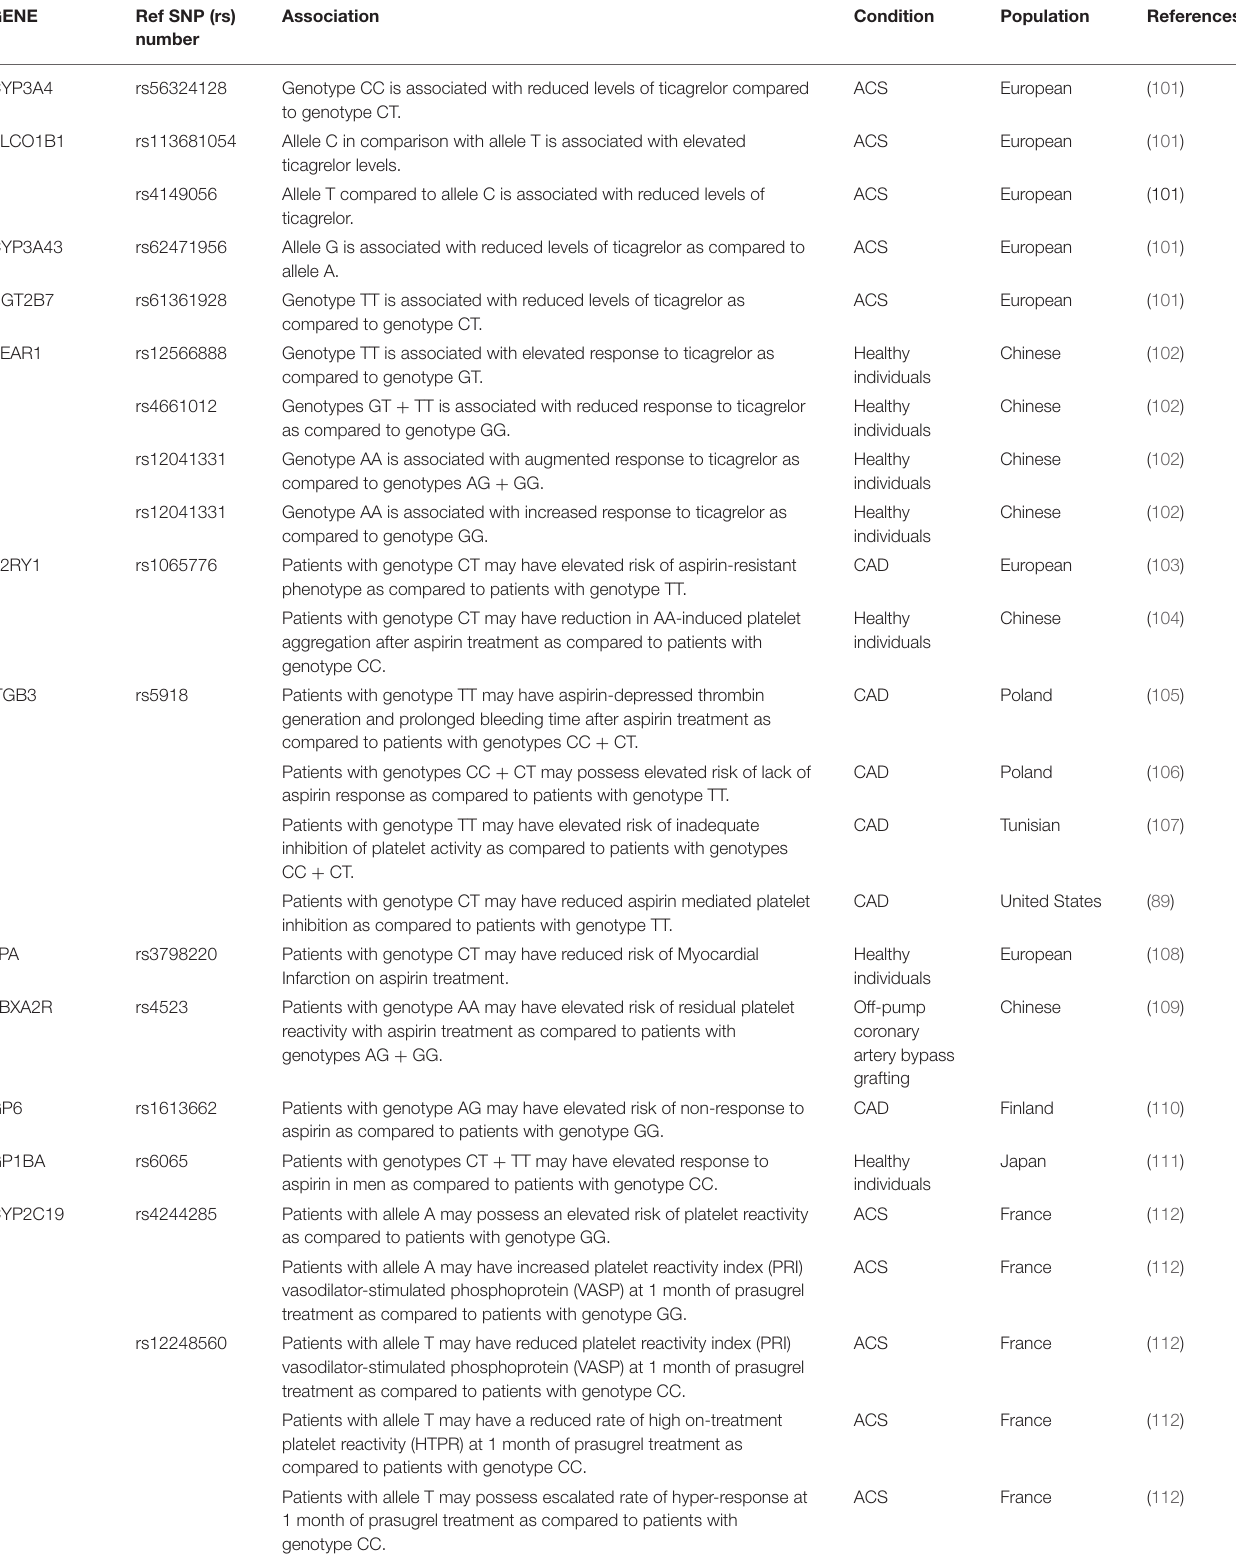
TABLE 2 | Pharmacogenetic variant association of antiplatelet drugs.